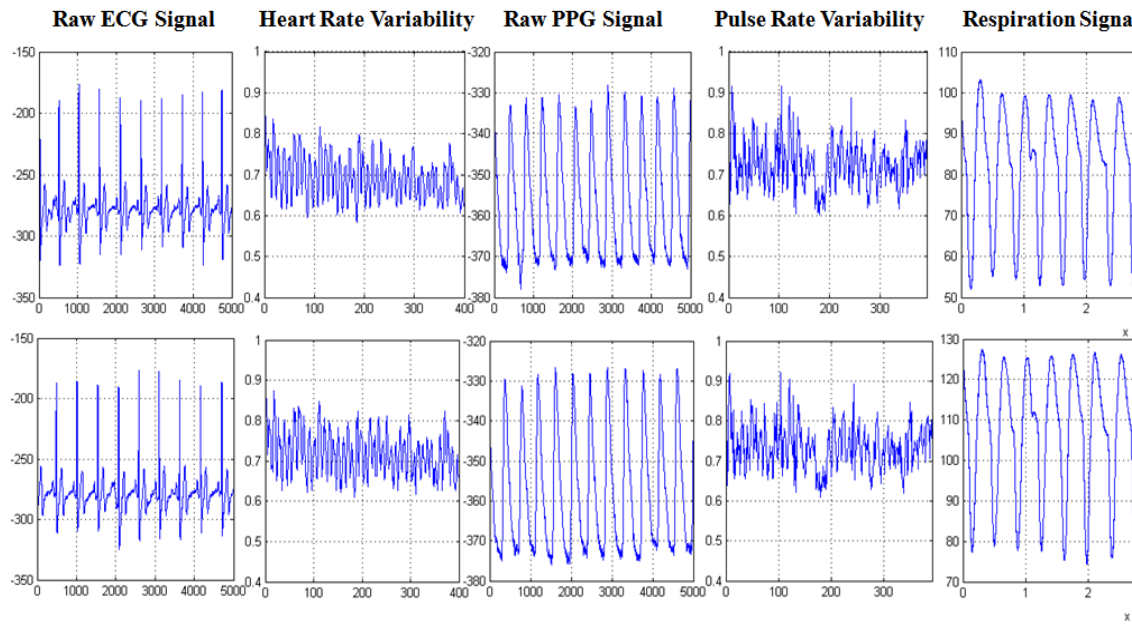
Figure 11. The performances comparison of LAXTHA PolyG-A system and our biofeedback system; raw ECG, PPG and respiration signal are recorded simultaneously by PolyG-A device and our device; HRV and PRV curve are also extracted simultaneously by Telescan and our software